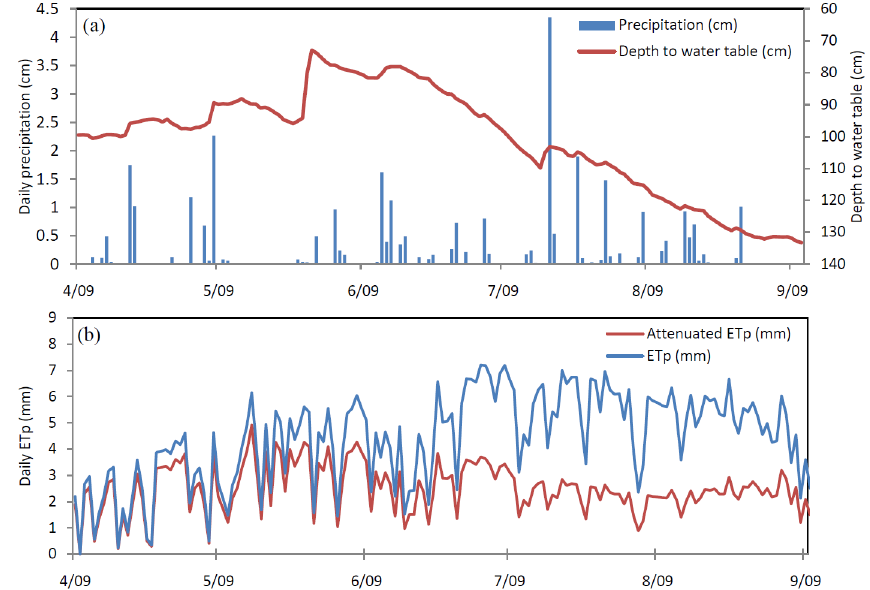
Fig. 2. (a) Observed daily precipitation and water table depth for the field site in south-central Nebraska during the 2009 growing season. (b) Daily ET p (calculated from the Priestley-Taylor equation) and “attenuated ET p ” for the understory vegetation (based on LAI-reduced net radiation due to overstory vegetation).